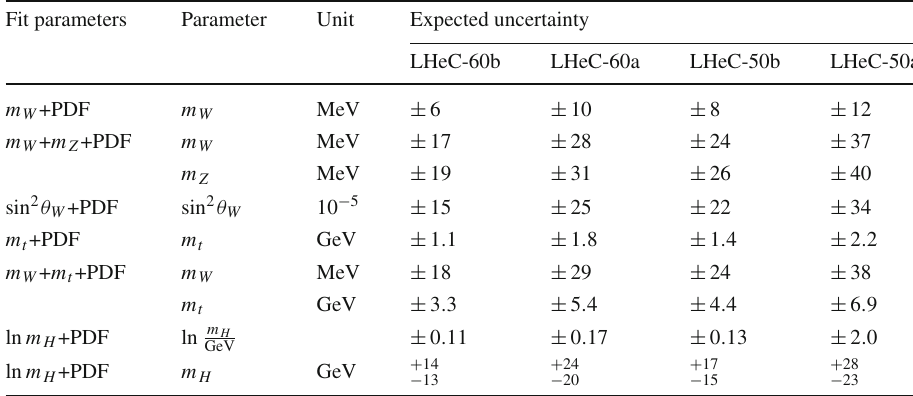
Table 10 Prospects for the determination of Standard Model parameters from simulated inclusive NC and CC DIS data at the LHeC.